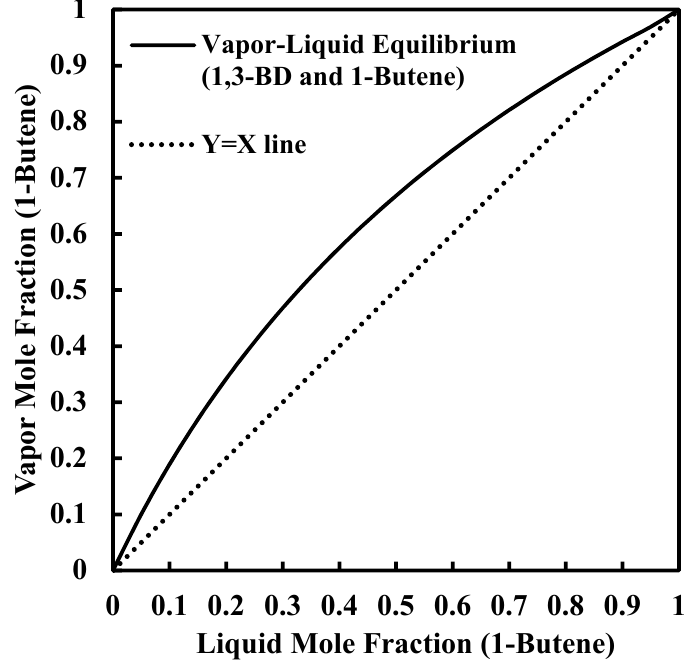
Figure 5. Vapor-liquid equilibrium curve of 1,3-BD and 1-butene upon introduction of N -methyl-2- pyrrolidone (NMP) .